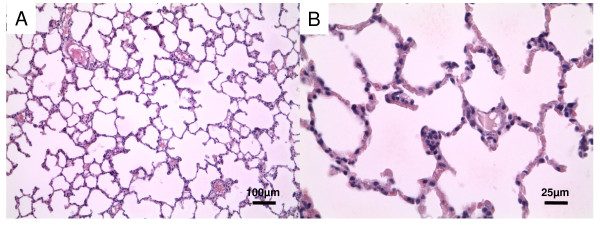
Lung sections from uninfected mice. Lung sections were hematoxylin-eosin stained. A - magnification ×10. B - magnification ×40.